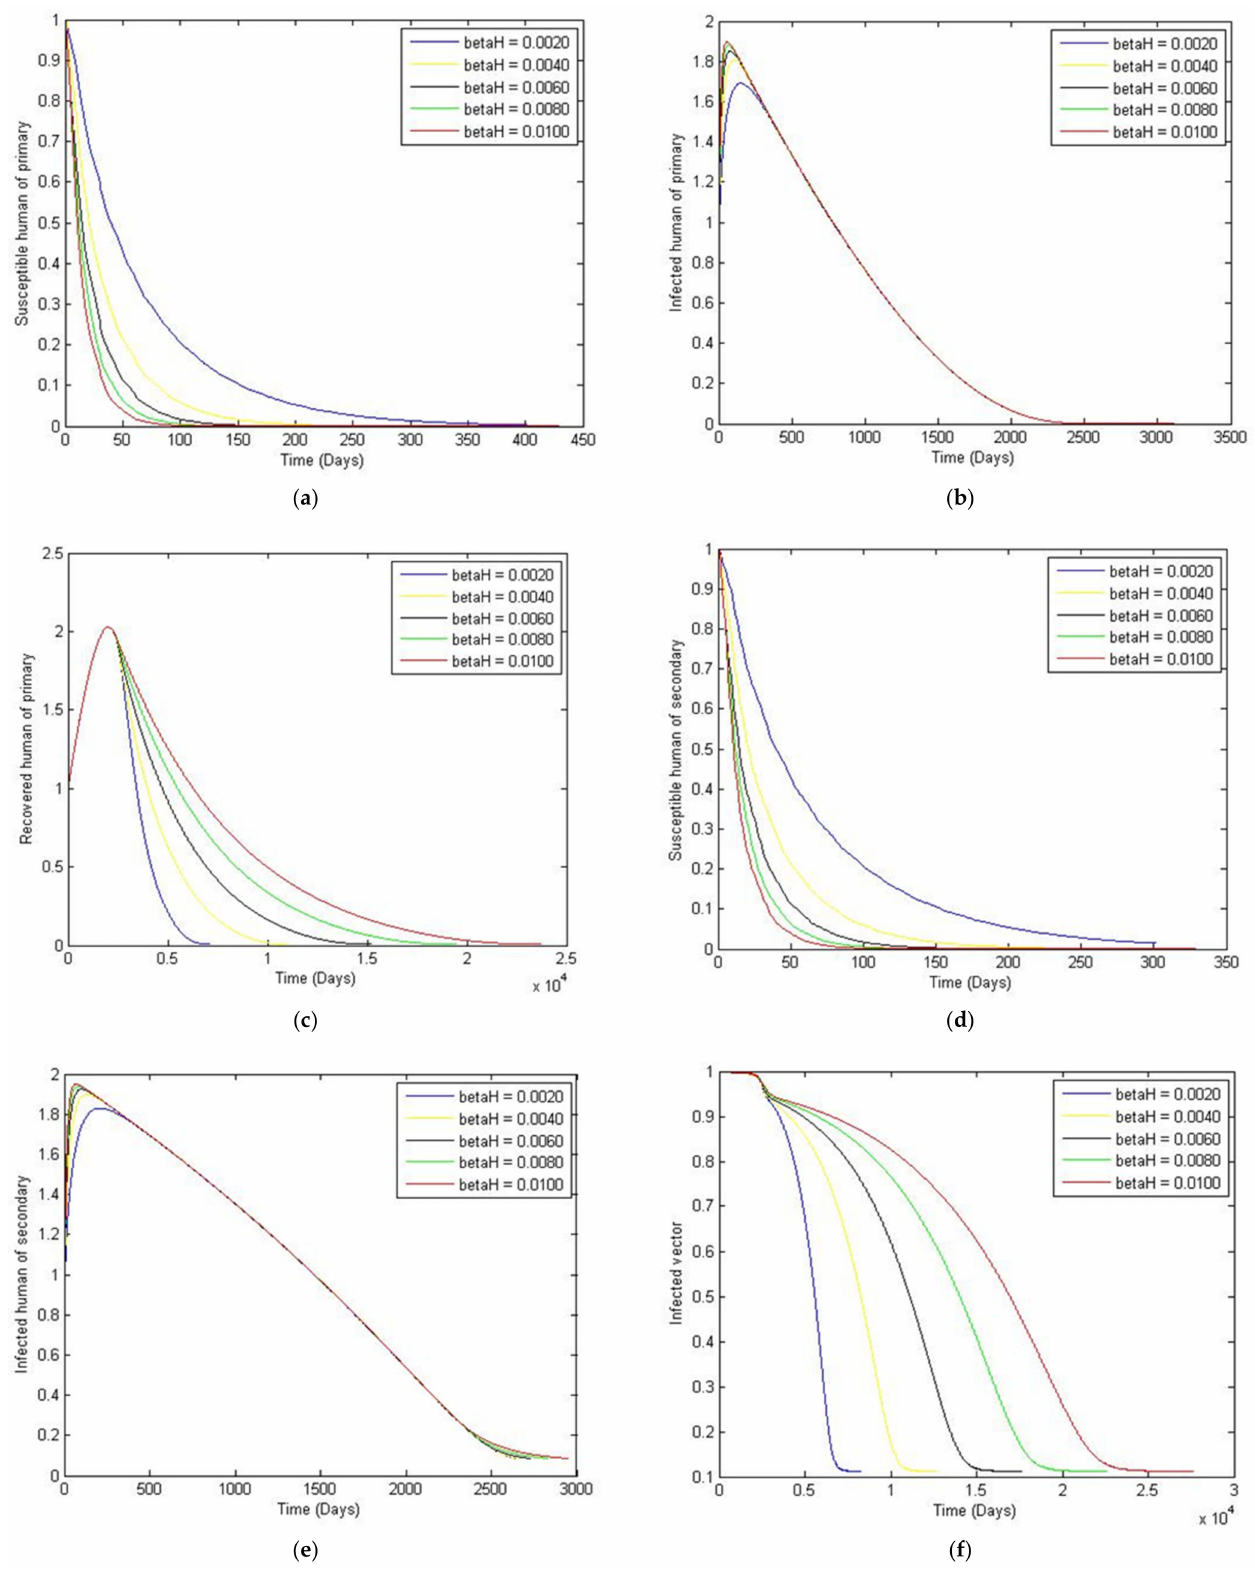
Figure 5. The trajectory of S HP , I HP , R HP , S HS , I HS and I V toward the endemic equilibrium point for R 0 > 1 with a comparison of the transmission rate of the dengue virus from vector to human, β H = 0.0020, 0.0040, 0.0060, 0.0080, 0.0100, and parameter values according to Table 3. ( a ) Susceptibles of primary infection ( b ) Infected population with primary infection ( c ) Recovered human of primary infection ( d ) Susceptibles of secondary infection ( e ) Infected human of secondary infection ( f ) Infected